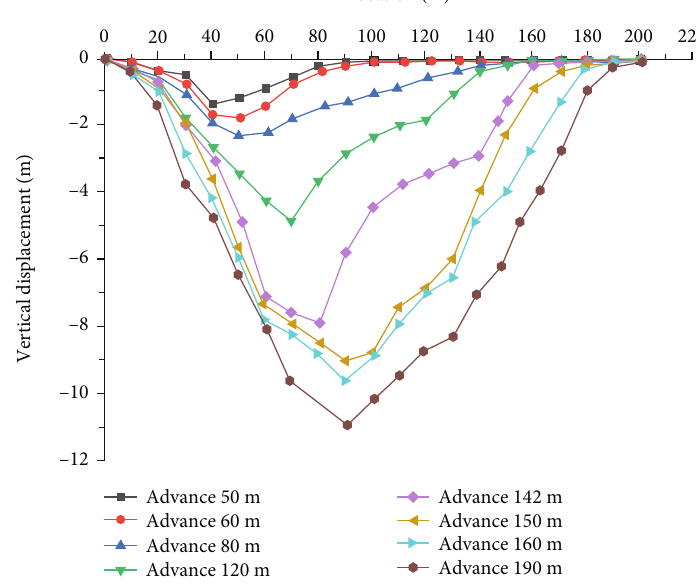
Figure 12: Overburden vertical displacement